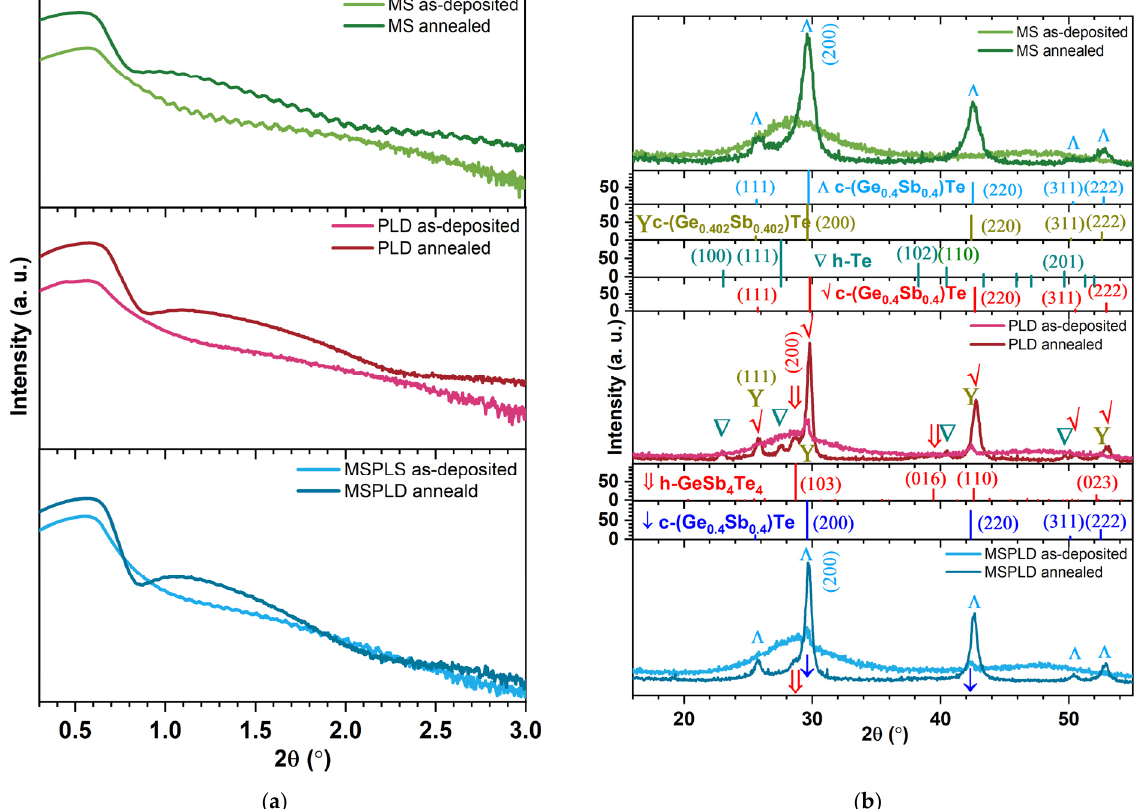
Figure 1. X-ray reflectometry (XRR) diagrams ( a ) and Grazing incident X-ray diffraction (GIXRD) patterns ( b ) for thin films of GST-225 deposited by: magnetron sputtering, pulsed laser deposition and simultaneously using the two methods in as-deposited states and after annealing at 200 °C.